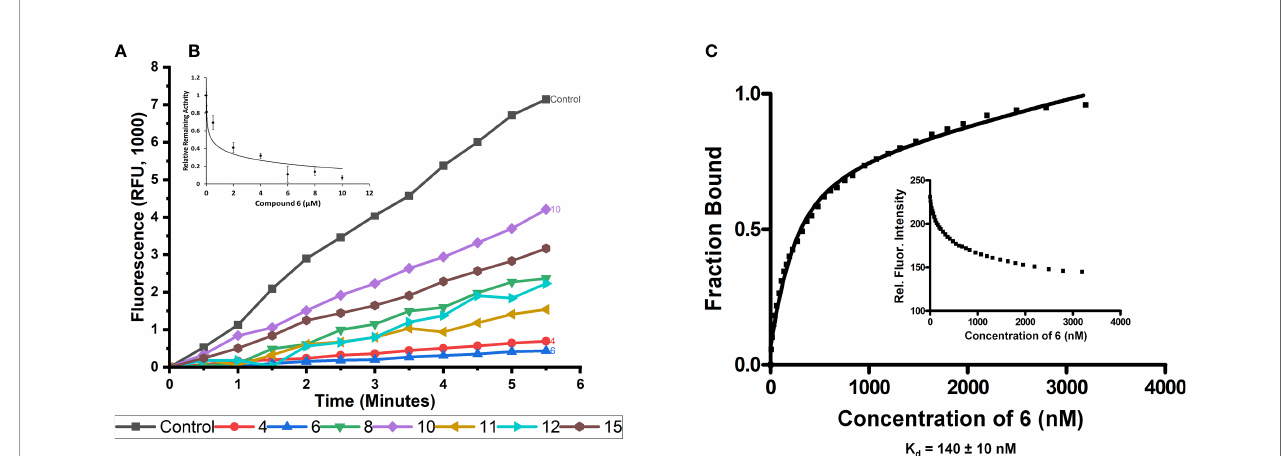
FIGURE 3 | In vitro inhibition of ERCC1-XPF endonuclease activity and binding of compound 6 to ERCC1-XPF. (A) ERCC1-XPF mediated cleavage of the stem-loop DNA substrate, in which the FAM signal is quenched, releases the fl uorescently tagged octanucleotide. A representative tracing of the effect of the different compounds (10 m M each) on the incision activity is shown. The inset (B) shows the initial velocities (slopes) obtained as indicated in (A) normalized by its value in the absence of compound, vs. its value in the presence of increasing micro molar concentrations of compound 6. The bars represent the S.D. of three different measurements for each point (R 2 = 0.96). (C) Binding af fi nity (Kd) measurement between ERCC1-XPF complex and compound 6. Representative plot of ERCC1-XPF fl uorescence quenching vs concentration of compound 6 to determine unimodal binding pattern (R 2 = 0.98). Protein fl uorescence was excited at 295 nm, and changes in fl uorescence intensity were monitored at the emission maximum (330 nm). The Kd value of 140 ± 10 nM was determined from three independent